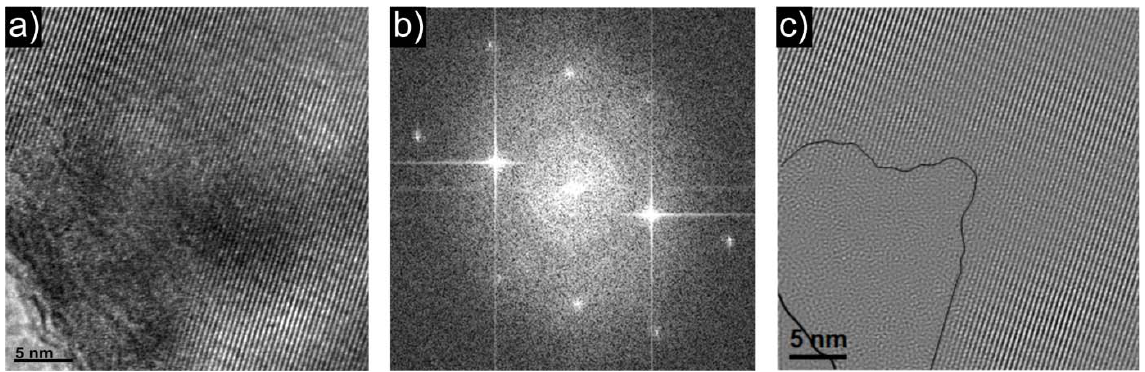
Figure 5. ( a ) HRTEM micrograph; ( b ) electron diffraction picture; and ( c ) HRTEM-based, FFT-analyzed picture of the structure of Li